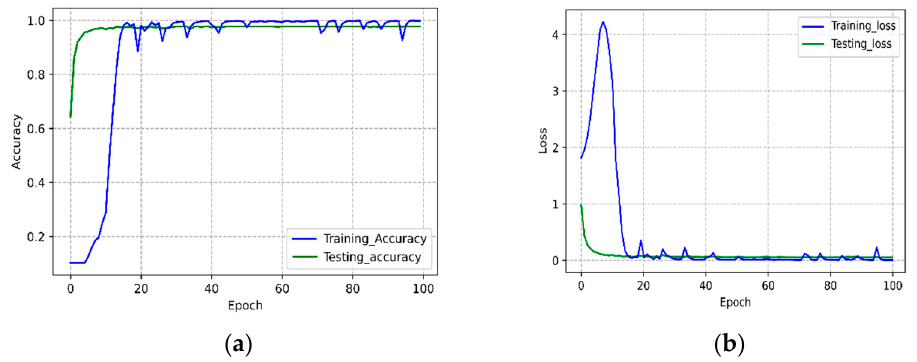
Figure 9. Accuracy ( a ) and Loss ( b ) graph of the STC-NLSTMNet model. T-SNE plots help assess the generalization ability of any model and how well the model reflects data in a large-scale feature dimension. Figure 10b illustrates the application effect of T-SNE where samples are well distributed and samples of the same class are grouped together. On the contrary, Figure 10a depicts the sample before applying T-SNE, where the samples are cluttered and difficult to identify. The clean and well-defined separation between all activities exhibited the capability of the proposed STC-NLSTMNet to partition the feature dimension.